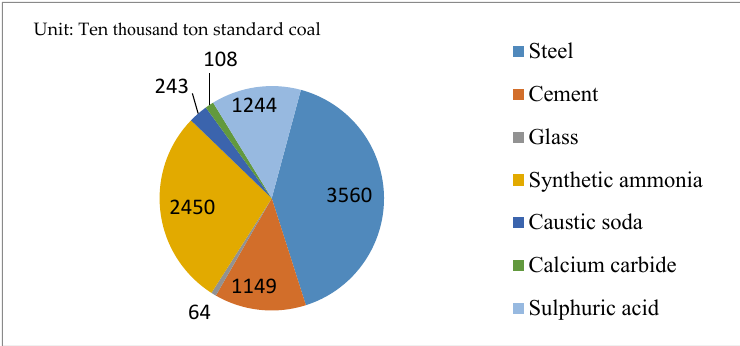
Figure 1. The amount of waste heat resources in seven industries.